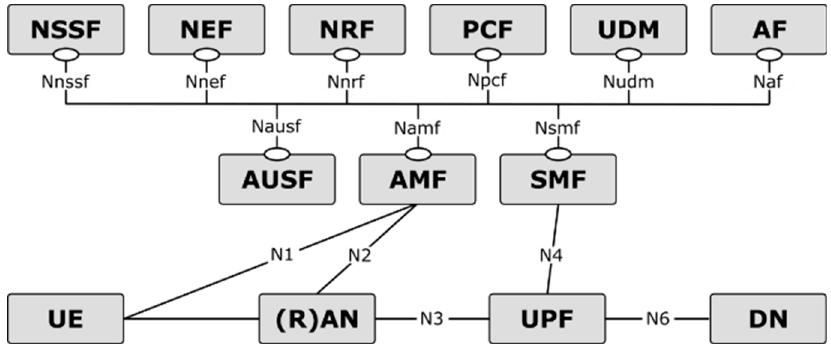
Figure 1. 5G system architecture [6].